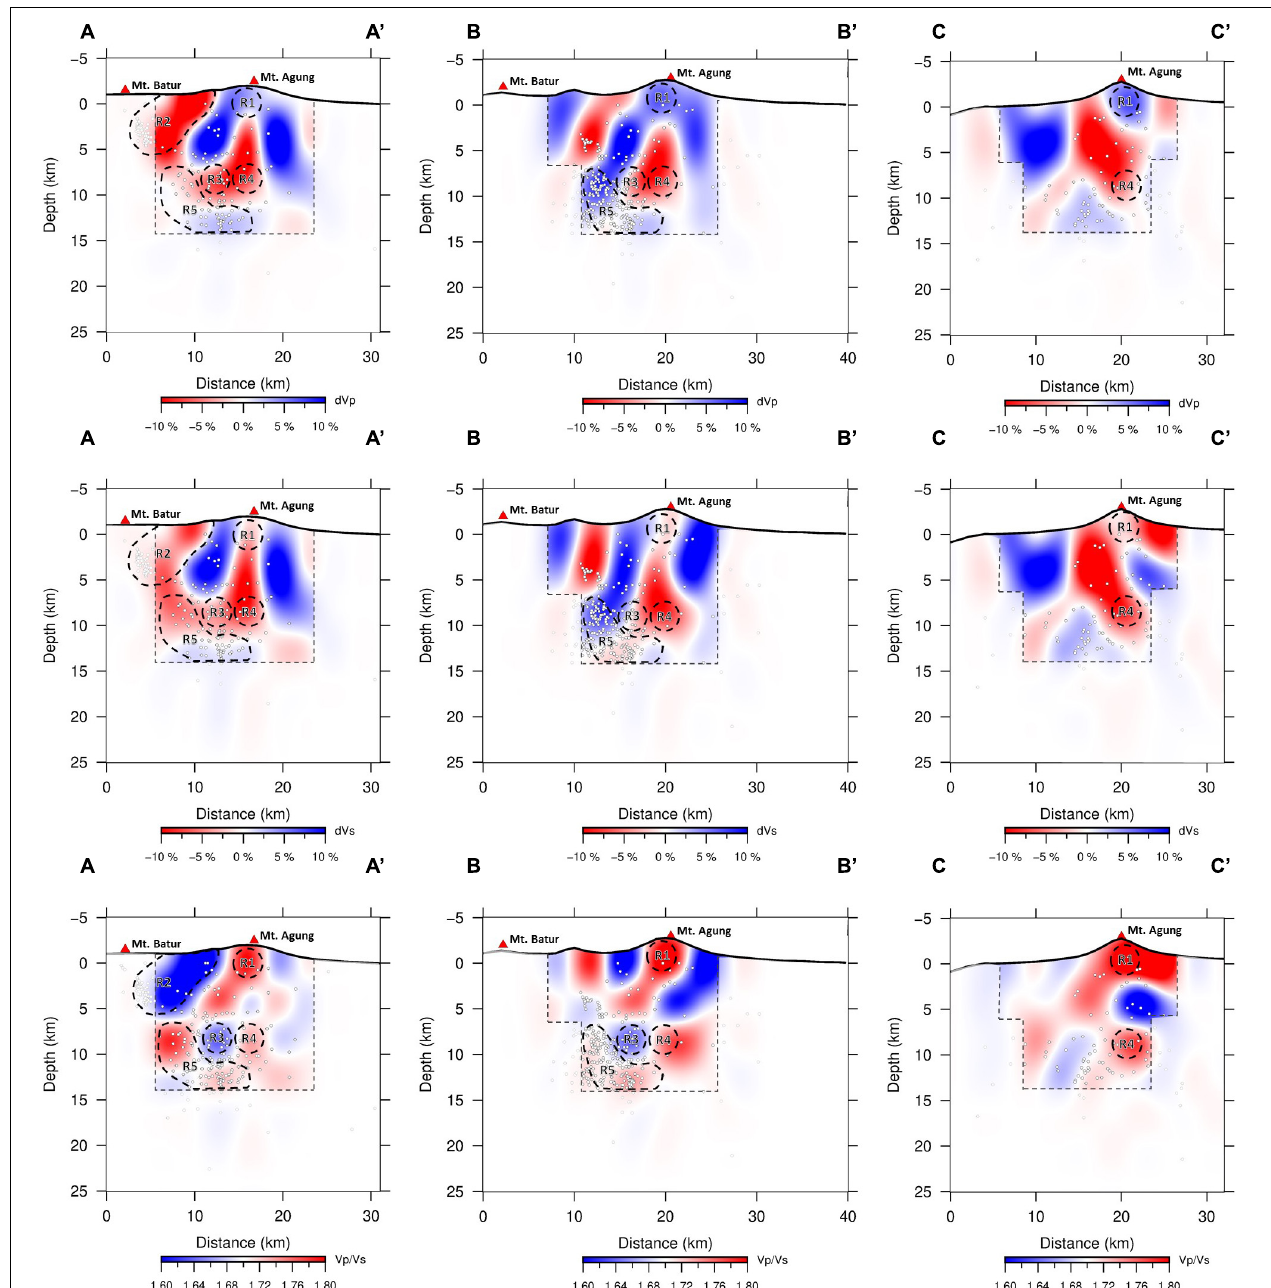
FIGURE 3 | The vertical cross-sections of the Vp, Vs, and Vp/Vs models from top to bottom, respectively; for slice (A-A’) (first column), (B-B’) (second column), (C-C’) (third column), the spatial location of each cross-section can be seen in Figure 1C . Blue and red colors respectively represent high and low seismic velocity anomaly values and inverted for Vp/Vs, according to the scale at the bottom of each column. Vp and Vs are plotted as percent perturbations relative to the 1-D optimum initial velocity model, and Vp/Vs are plotted as absolute values. The white dot represents the hypocenter’s projection to the vertical cross-section; only events with depths less than 0.5 km from the centerline are plotted here. Dashed black lines define the area which has a good resolution based on resolution test results. Labeled regions (R1–R5) depicted by these figures are discussed in the text.